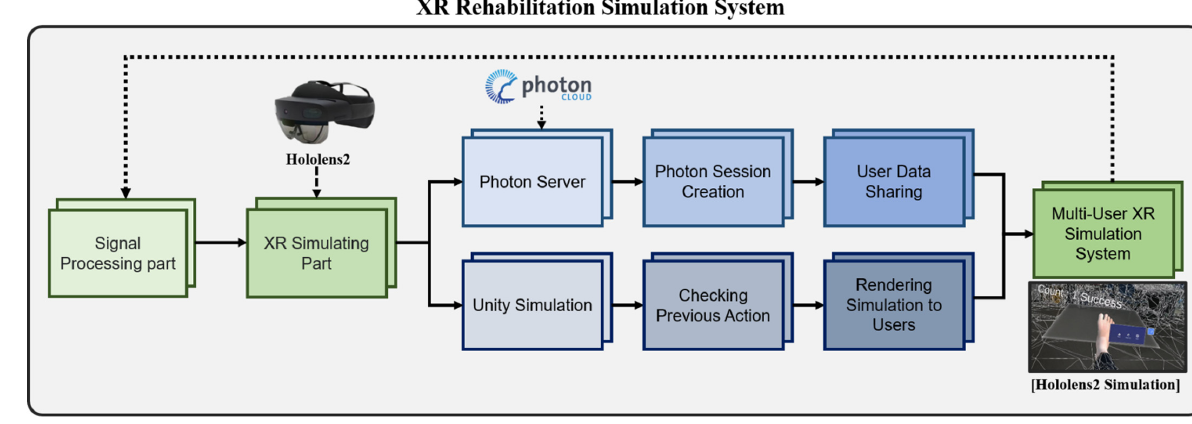
Figure 3. The architecture of the XR Rehabilitation System.